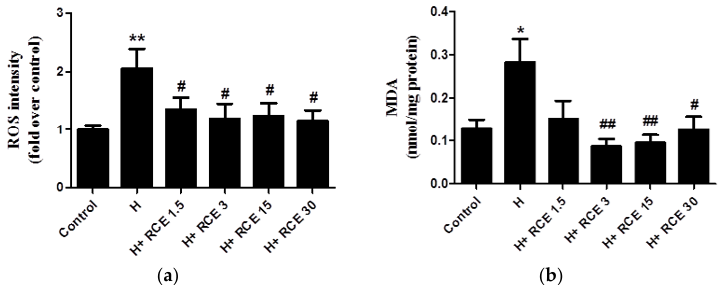
Figure 3. Effect of Rhodiola crenulata root extract on hypoxia-induced reactive oxygen species formation and lipid oxidation. HUVECs were pretreated with vehicle or RCE (μg/mL) and then exposed to hypoxia (1% O 2 ) for 24 h. Afterwards, oxidative stress markers were detected with 2,7-dichlorofluorescein diacetate (DCFH-DA) ( a ) and MDA ( b ) assays as described in Materials and Methods. Results represent the mean ± SEM ( n = 6). * p < 0.05; ** p < 0.01 versus control; # p < 0.05; ## p < 0.01 versus hypoxia.